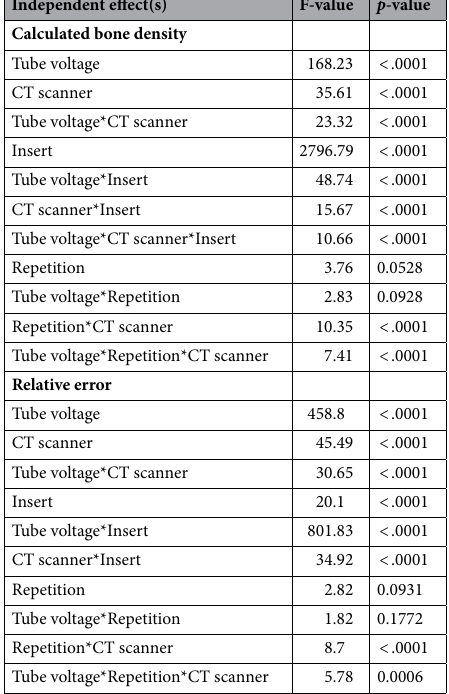
Table 3. Results of statistical analysis from the two general linear models for the calculated bone density and the relative error, showing the F- and p-values for the remaining effects. Interaction effects are indicated by an asterisk between the individual effects. Note that non-significant effects can remain part of the model if they appear in significant interaction effects (i.e.